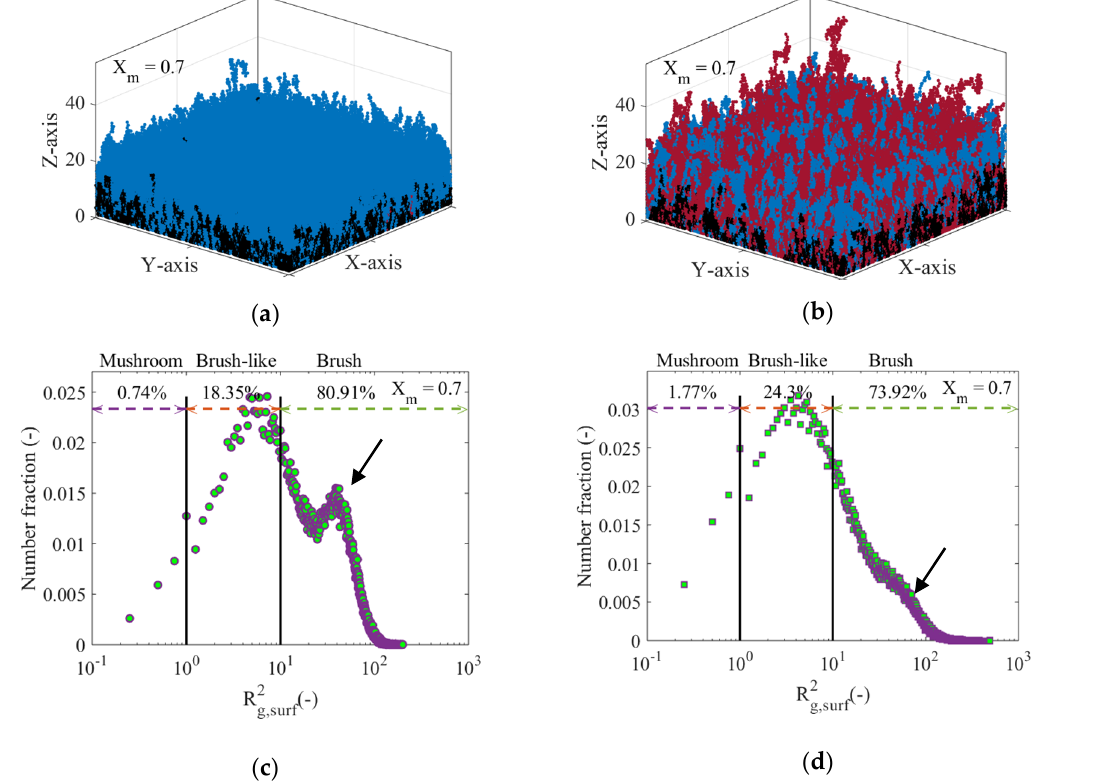
Figure 12. Snapshot of the polymer layer grown from RDRP initiator ( R 0 ,surf X ) molecules chemically anchored on the flat surface with θ R = 0.25 for the two termination modes under consideration: 0, sur X ( a ) translational mode and ( b ) segmental mode; analogous plots for the total distribution of the squared radius of gyration ( R 2 ) of individual surface-tethered polymer chains: ( c ) translational mode and g , surf ( d ) segmental mode. Same simulation conditions as in Figure 11. All the subplots are obtained at a monomer conversion X m = 0.7. Subplots ( a , c ) are the same as in Figures 7c and